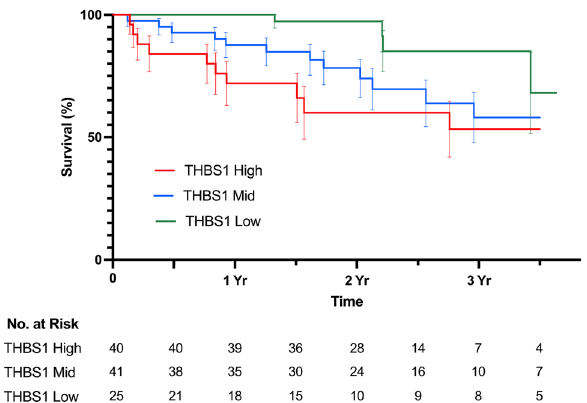
Figure 4. Kaplan Meier curves depicting freedom from death after lower extremity revascularization by tertile of pre-operative THBS1